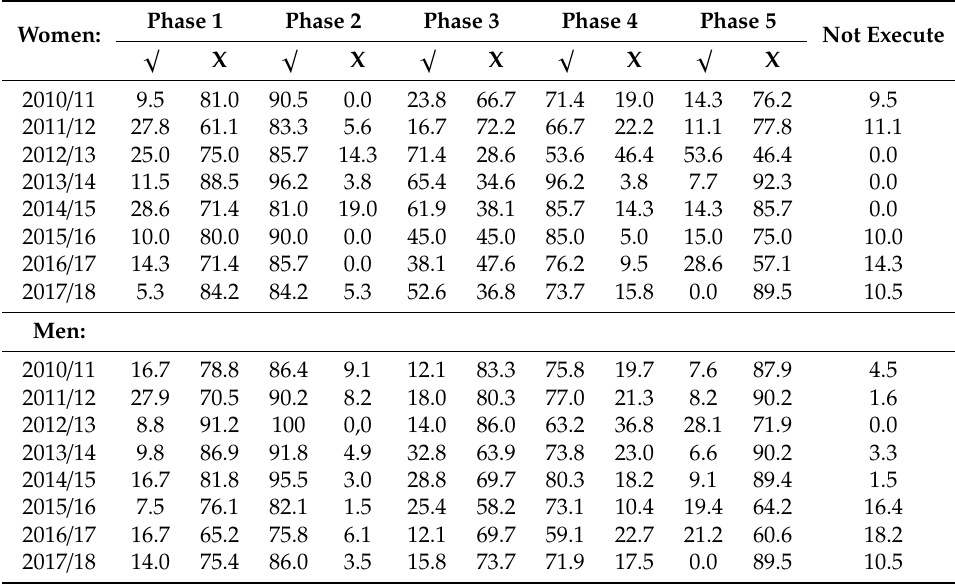
Table 3. Analysis of technical execution of cartwheel, according to movement phase and gender.